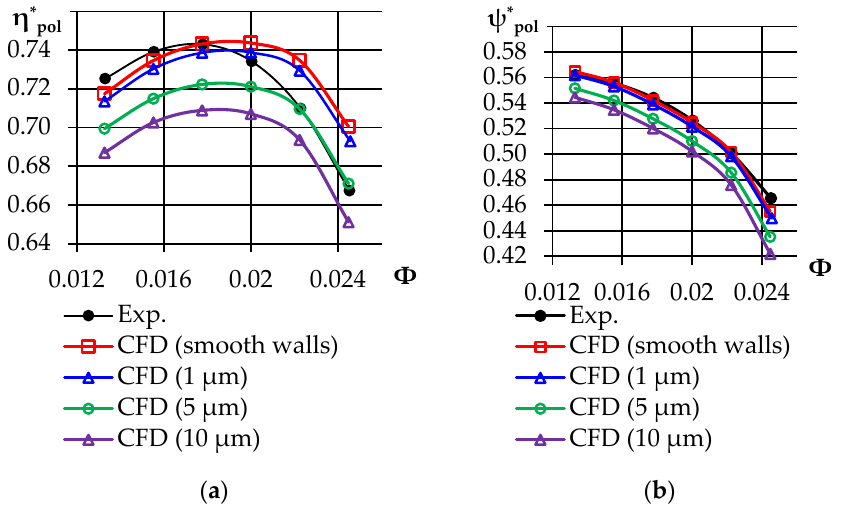
Figure 5. Results of the sand roughness influence study on the results of modeling the Q-482 model stage: ( a ) Polytropic efficiency on total parameter; ( b ) Polytropic head coefficient on total parameter.